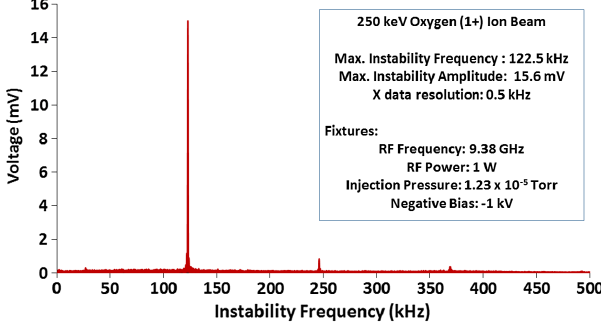
FIG. 3. Maximum plasma instability frequency for the oxygen ion beam under a set of fixtures of ECR source as given in the